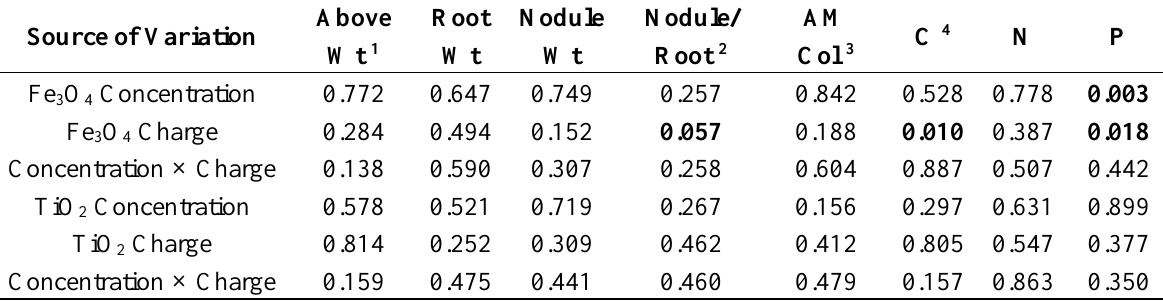
Table 2. Results of two-way ANOVA using the general linear model for effects of nanoparticle concentration and charge on plant growth performance. p values are shown where significant differences ( p < 0.1) are in bold. Note: nutrient contents refer to leaf tissue